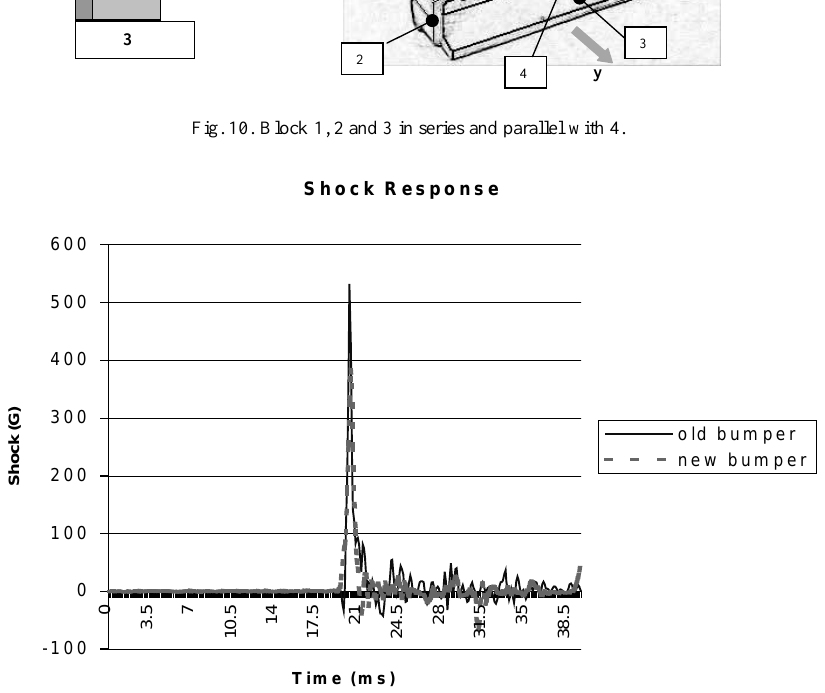
Fig. 11. Shock level due to tilt test using old and new shock